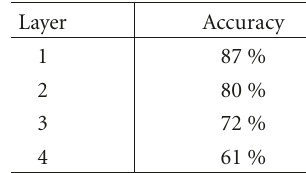
Table 1: Overall accuracy. Table 2: Mapping between class